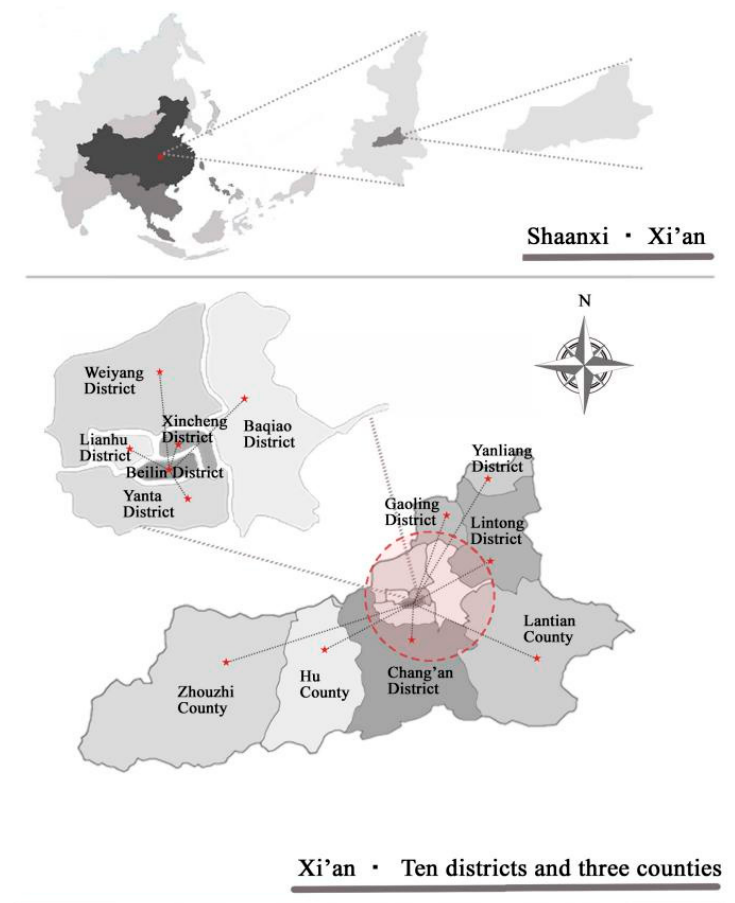
Figure 3. Research Figure 3. Research sites.